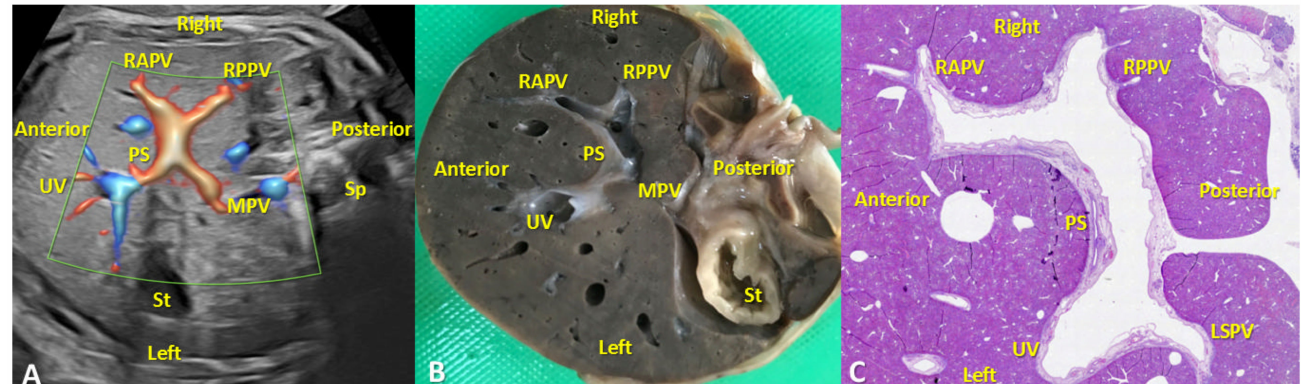
Figure 5. Transverse planes at the level of PVS in the second trimester of pregnancy. ( A ):Transverse plane of the upper abdomen with color Doppler evaluation, showing hepatic course of the umbilical vein (UV), the L-shaped portal sinus (PS), the junction of the PS with the main portal vein (MPV), the left portal vein, the right portal vein and its branches. ( B ): Normal macroscopically appearance of the liver demonstrating the PS, MPV, UV, LSPV, RAPV, RPPV. St-stomach. Sp- spleen. PS: portal sinus, MPV: main portal vein, UV: umbilical vein, LSPV: left portal vein and the superior branch, RAPV: right anterior portal branch, RPPV: right posterior portal branch. ( C ): Transverse section in the hepatic parenchyma which allowed the identification of the PS, UV, LSPV, RAPV, RPPV. Classic hematoxylin-eosin staining, ×